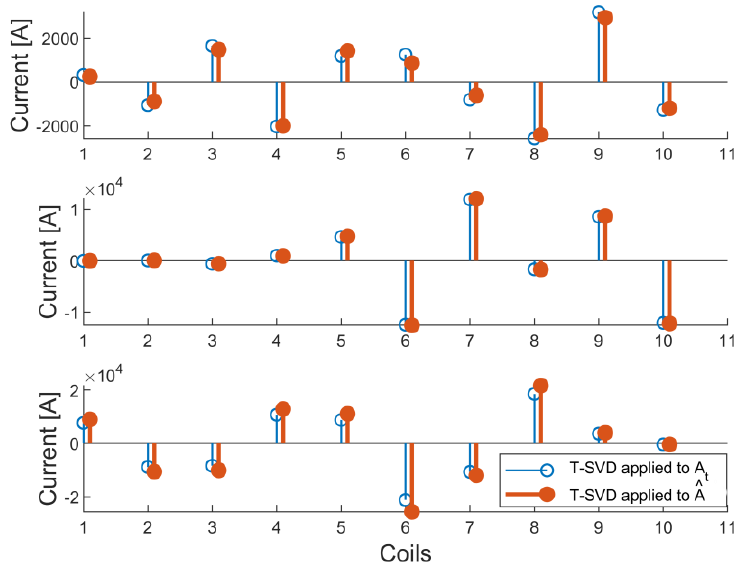
Figure 7. Currents from T-SVD method (8 singular values retained) applied to A currents from ˆA (red dot): cylinder case (Dataset 1): up, diverging cylinder (Dataset 2): middle, converging cylinder (Dataset 3):